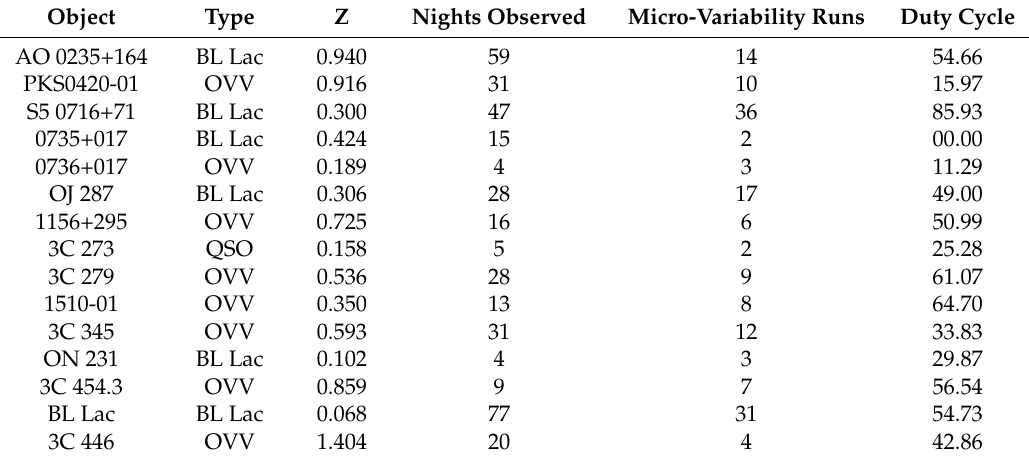
Figure 2. Starship control room being used to control remote telescopes at Kitt Peak National Observatory (KPNO) and Cerro Tololo Interamerican Observatory (CTIO). Table 1. Source list for the FIU Blazar Micro-variability